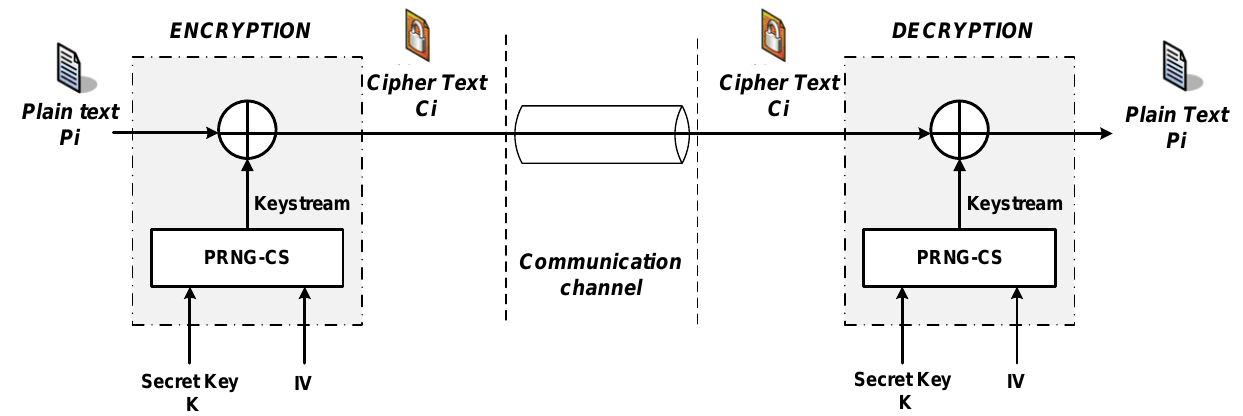
Figure 5. A stream encryption/decryption system’s block diagram.